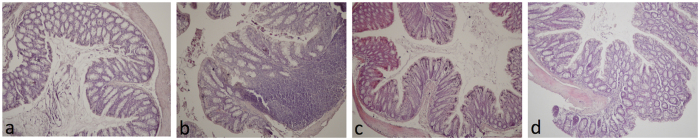
Histological evaluation of colon inflammatory cell infiltration in female and male BTBR mice.Representative hematoxylin and eosin–stained sections from colon tissues of mice. (a) Colon tissue from mC57 mice showing absence of inflammatory cells. (b) Colon tissue of mBTBR group showing leukocyte infiltration in the mucosa and submucosa. (c) Colon tissue of fC57 group, showing absence of inflammatory cells. (d) Colon tissue from fBTBR group showing moderate leukocyte infiltration in the mucosa. Original magnification 10x. Histological evaluation of inflammatory cells infiltration was scored along the entire colon length, inspecting the colon mucosa, submucosa and transmural areas considering the following parametres: leukocyte density (mC57 = 0.33 ± 0.58, mBTBR = 2 ± 1, fC57 = 0, fBTBR = 2.67 ± 0.58) and expansion of leukocyte infiltration (mC57 = 0.33 ± 0.58, mBTBR = 1.33 ± 0.58, fC57 = 0, fBTBR = 1.67 ± 0.58). The histologic scoring system is reported in Material and Methods section. Data reported as mean ± SD, n = 3/group.